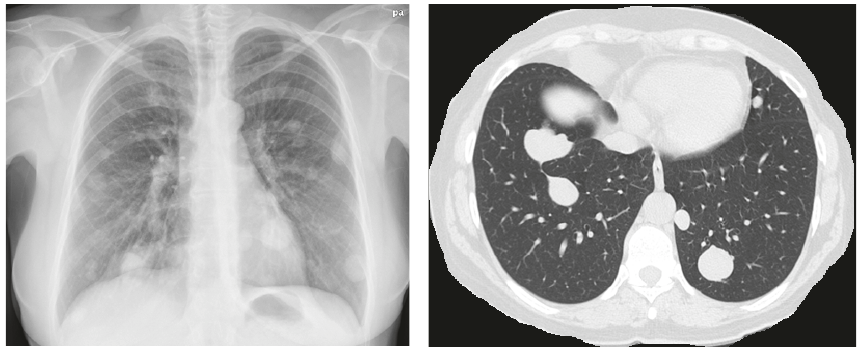
Figure 2: Chest radiography and CT images of patient